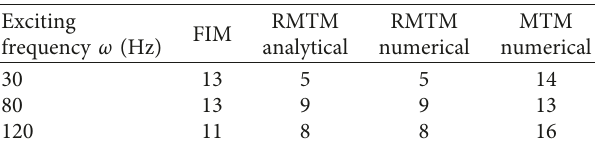
Table 2: Mode number needed for convergence using different